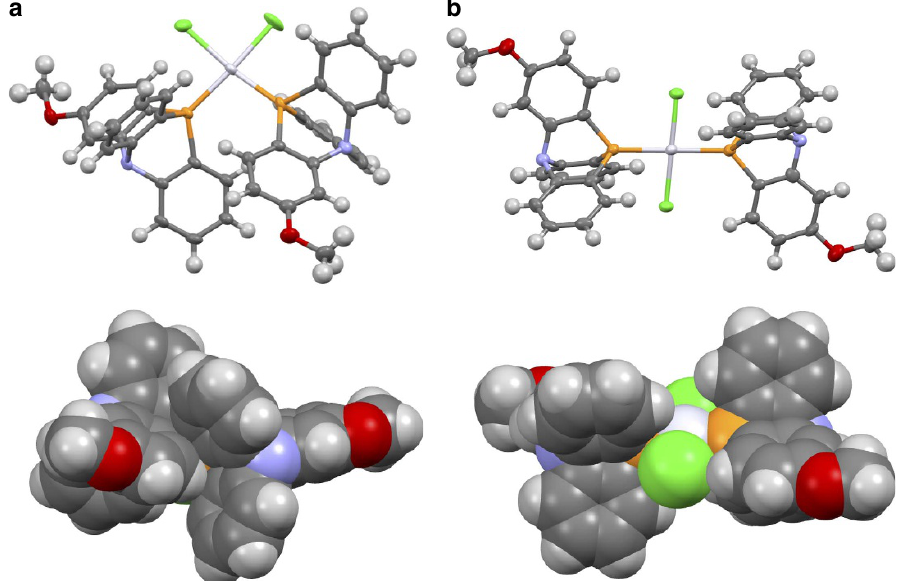
Figure 3 | X-ray crystal structures of cis - and trans -PtCl 2 1 2 . ( a ) cis -PtCl 2 1 2 (cid:3) (ether). ( b ) trans -PtCl 2 1 2 (cid:3) (C 6 H 6 ) 2 . In both cases, the structures are indicated as ORTEP (Oak Ridge Thermal Ellipsoid Plot) diagram with 50% thermal ellipsoid (upper) and space-filling model (bottom). Solvents are omitted for clarity, and colours are coded according to CPK (Corey, Pauling, Koltun) colouring.